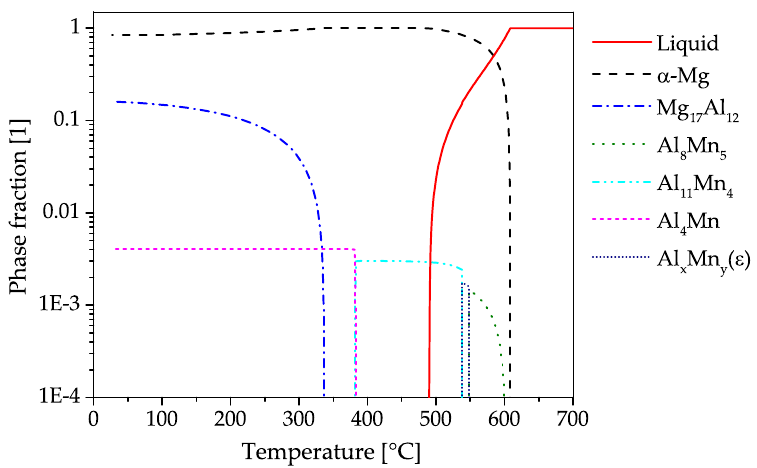
Figure 12. CALPHAD calculations (for further information see Appendix A) of AZ71 in a temperature range of 25 to 700 ◦ C, showing phase fractions of 10 − 4 to